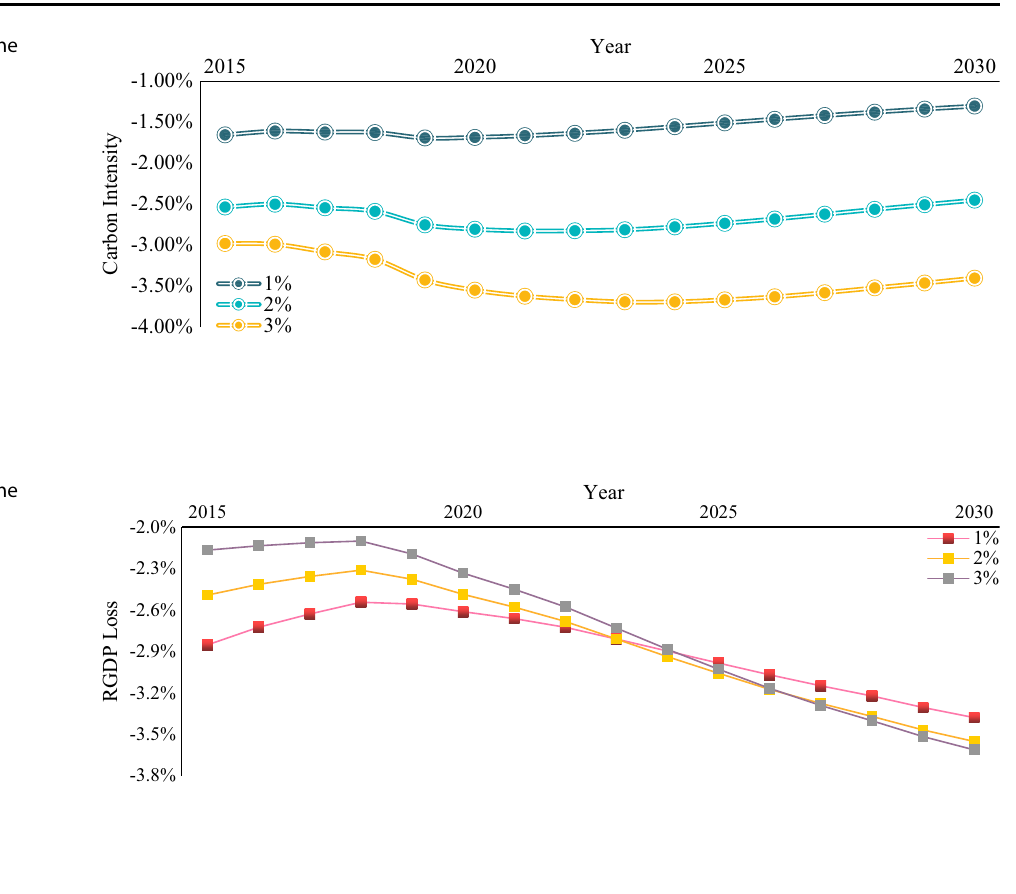
Fig. 8 The relative change of the household welfare loss